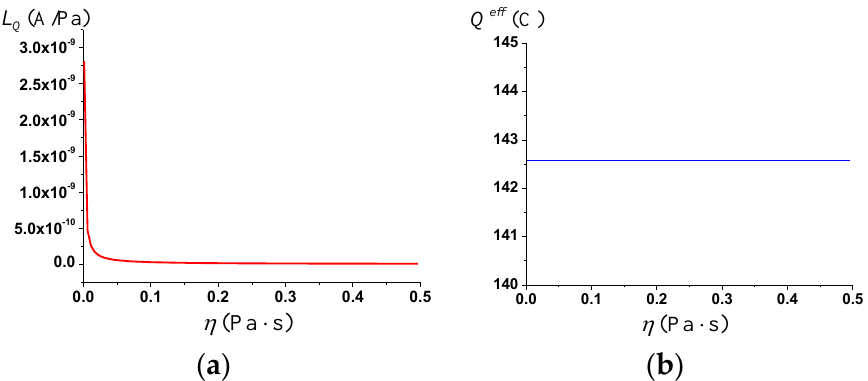
Figure 9. Effect of water viscosity (time-harmonic case): ( a ) streaming current coupling coefficient; ( b ) effective net residual charge density.